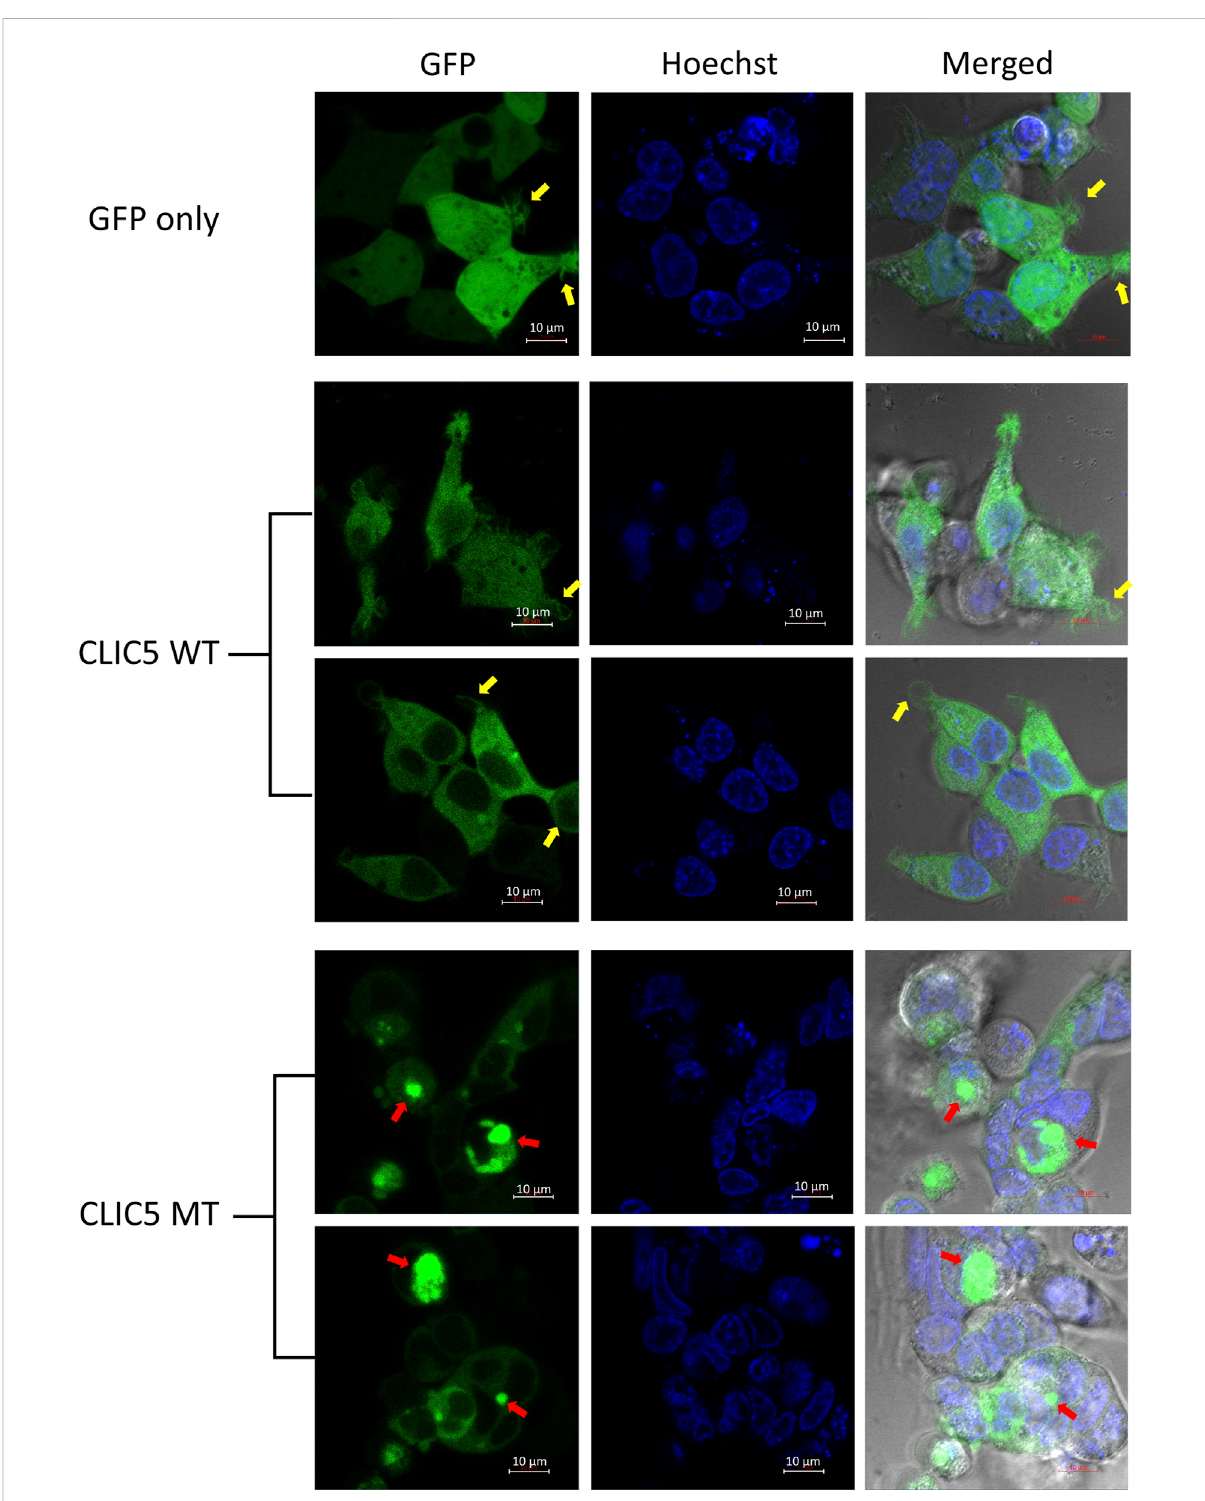
FIGURE 2 CLIC5A MT and not WT are aggregated into sub-cellular compartments. Live HEK293 cells expressing WT or MT GFP-tagged CLIC5A protein andstainedwithHoechstwereobservedusingconfocalmicroscopy48 hposttransfection.Theyellowarrowspointtothinmembrane fi lopodia-like protrusions observed in the WT transfected cells and the red arrows point to CLIC5 MT protein